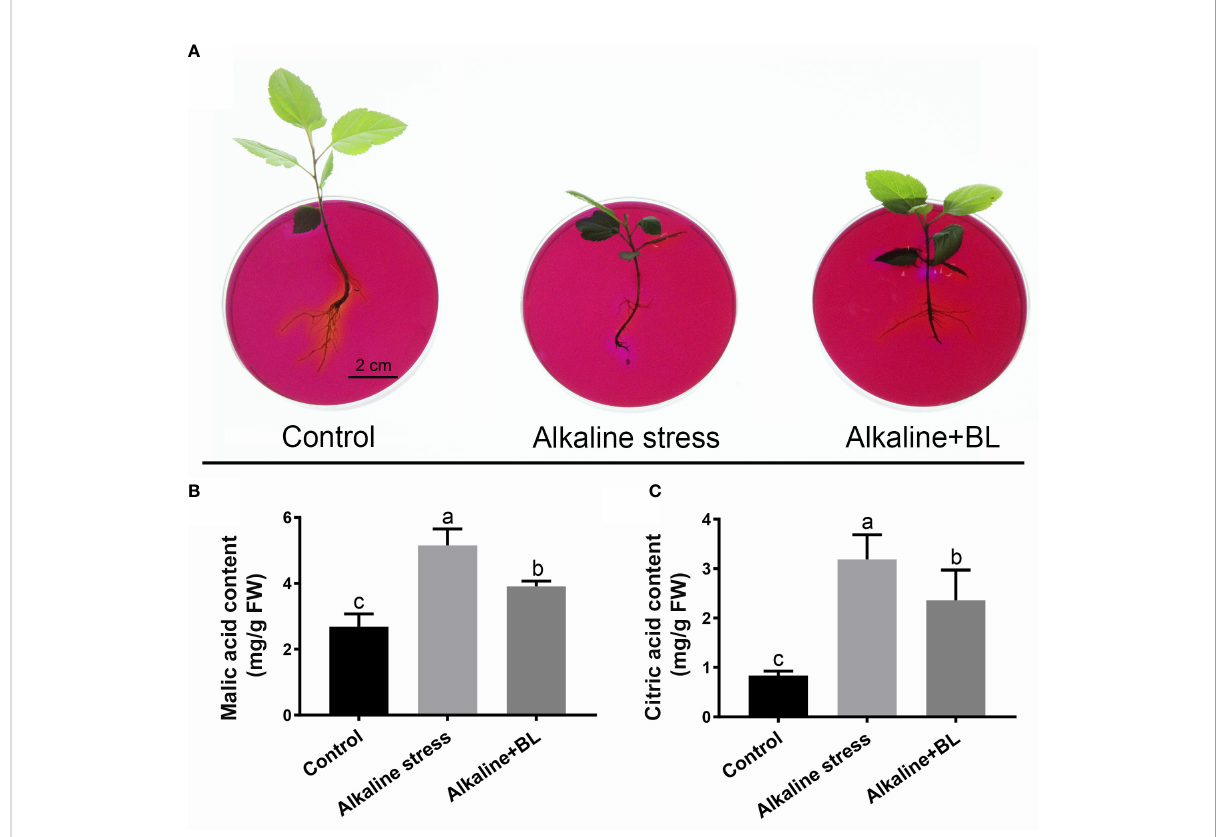
FIGURE 4 Effects of exogenous BL on rhizosphere pH and organic acid contents of M. hupehensis under alkaline stress. (A) Effects of alkaline stress and exogenous BL on rhizosphere pH of the seedlings by bromocresol violet staining. The scale bar represents 2.0 cm. Effects of alkaline stress and exogenous BL on malic acid content (B) and citric acid content (C) of the seedlings at day 15. The data represent the mean ± SD of three biological replicates. Different lowercase letters indicate signi fi cant differences according to Fisher ’ s least signi fi cant difference ( P <